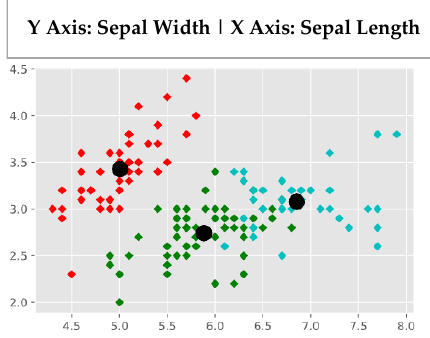
Figure 8. Correctly modeled Iris clusters.